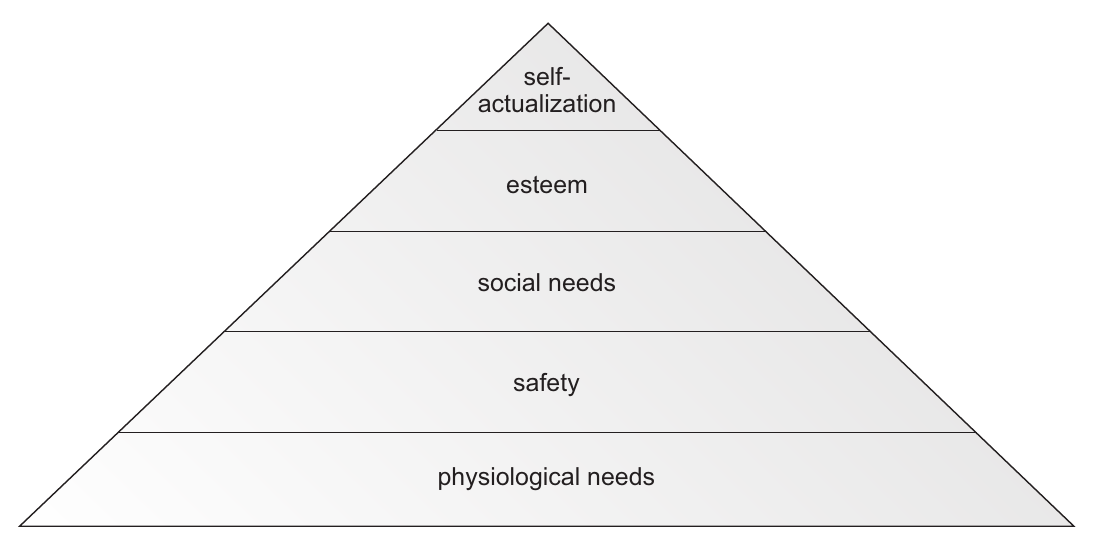
Fig. 1. maslow’s hierarchy of needs. Source: own elaboration based on Maslow.